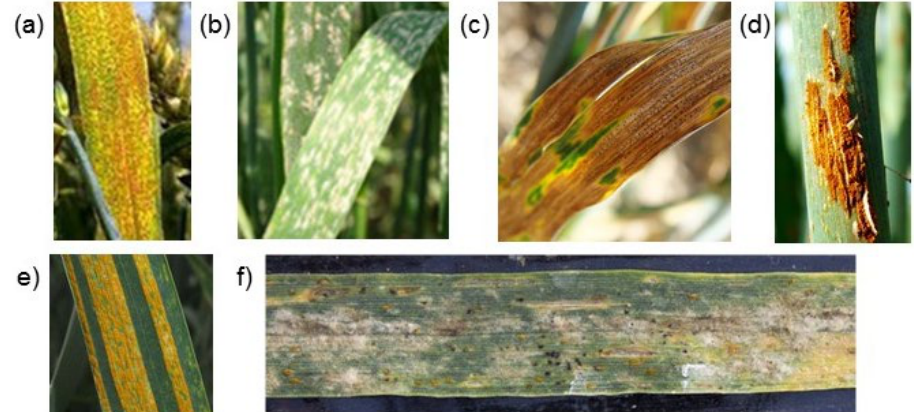
Figure 1. Examples of digital images showing manifestations of wheat plant disease: ( a ) leaf rust, ( b ) powdery mildew, ( c ) septoria, ( d ) stem rust, ( e ) yellow rust, and ( f ) multiple diseases. Leaf rust, powdery mildew, and septoria (pathogens Puccinia triticina Erikss., Blume- ria graminis (DC.) Speer, Zymoseptoria tritici Rob., and Parastaganospora nodorum Berk.) are cosmopolitan pathogens. They are observed in the phytopathogenic complex on grain crops widely. However, the total damage caused by the causative agents of the above- listed diseases does not exceed 20% and is controlled by the timely use of fungicides [3].